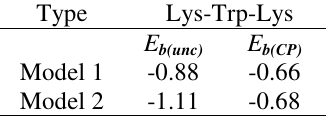
Table 3 . Uncorrected binding energies, E energies, E (eV) . b(CP)